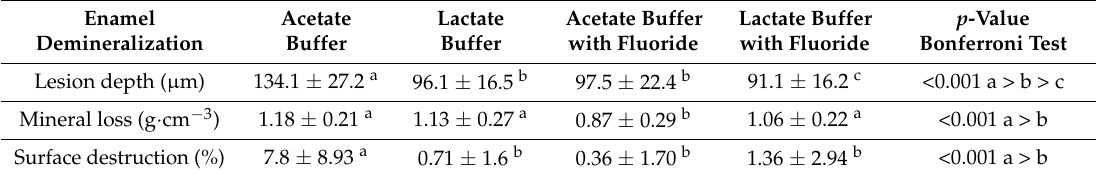
Mean lesion depth, mineral loss and surface destruction percentage of the four experimental